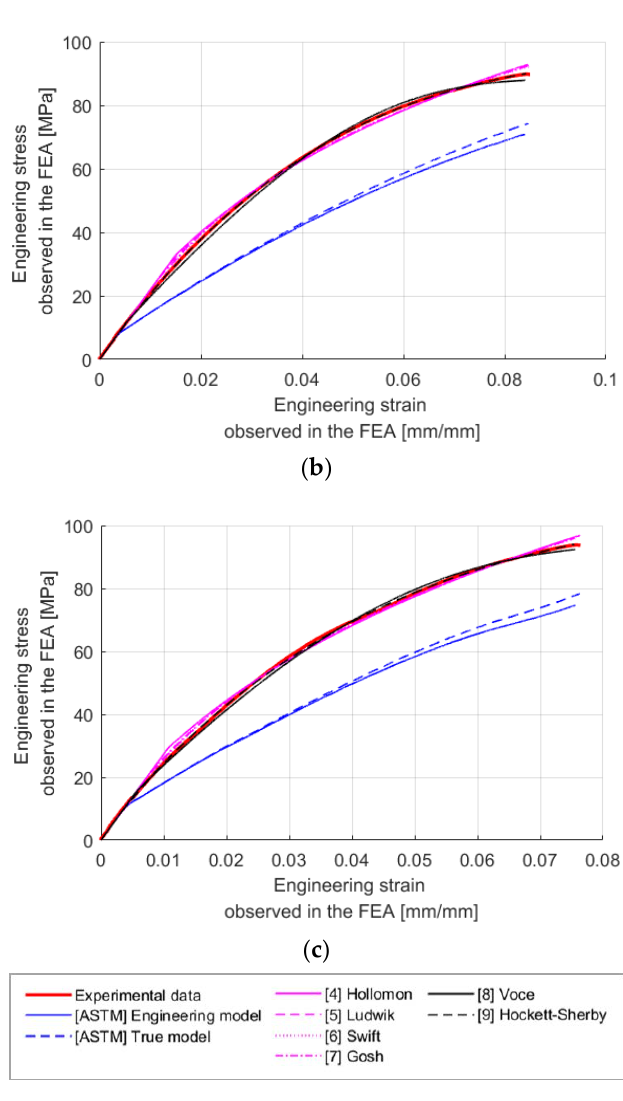
Figure 9. Engineering S–S curve of the optimized models: ( a ) inverse models of GFRP wt 20%GF; ( b ) inverse models of GFRP wt 30% GF; ( c ) inverse models of GFRP wt 40% GF.